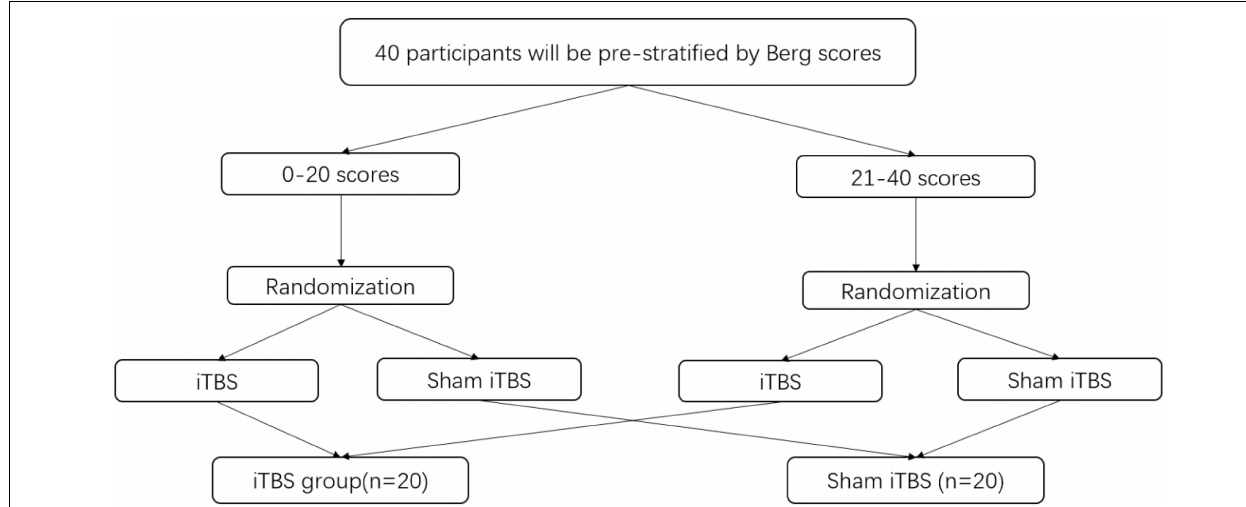
FIGURE 2 | Flow chart of random grouping procedure.